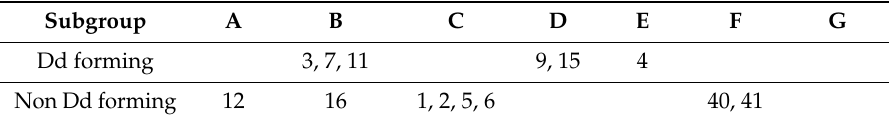
Table 2. Subgroups and dodecahedron formation. human adenovirus (HAdV) serotypes belonging to di ff erent subgroups are classified according to dodecahedron formation. Note that dodecahedrons have never been observed in the well-studied subgroup C and that subgroup B contains both dodecahedron-forming and non-dodecahedron forming